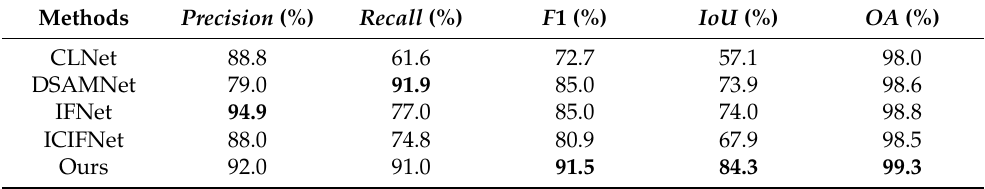
Figure 5. Illustrations of BuCD results on the WHUCD dataset. Six pairs of multi-temporal images are shown from ( a – f ). White represents the correctly identified changing buildings. Additionally, red and green denote the false and missed predictions of changed buildings, respectively. Table 3. Quantitative analysis of the WHUCD dataset. The highest metrics are in bold.